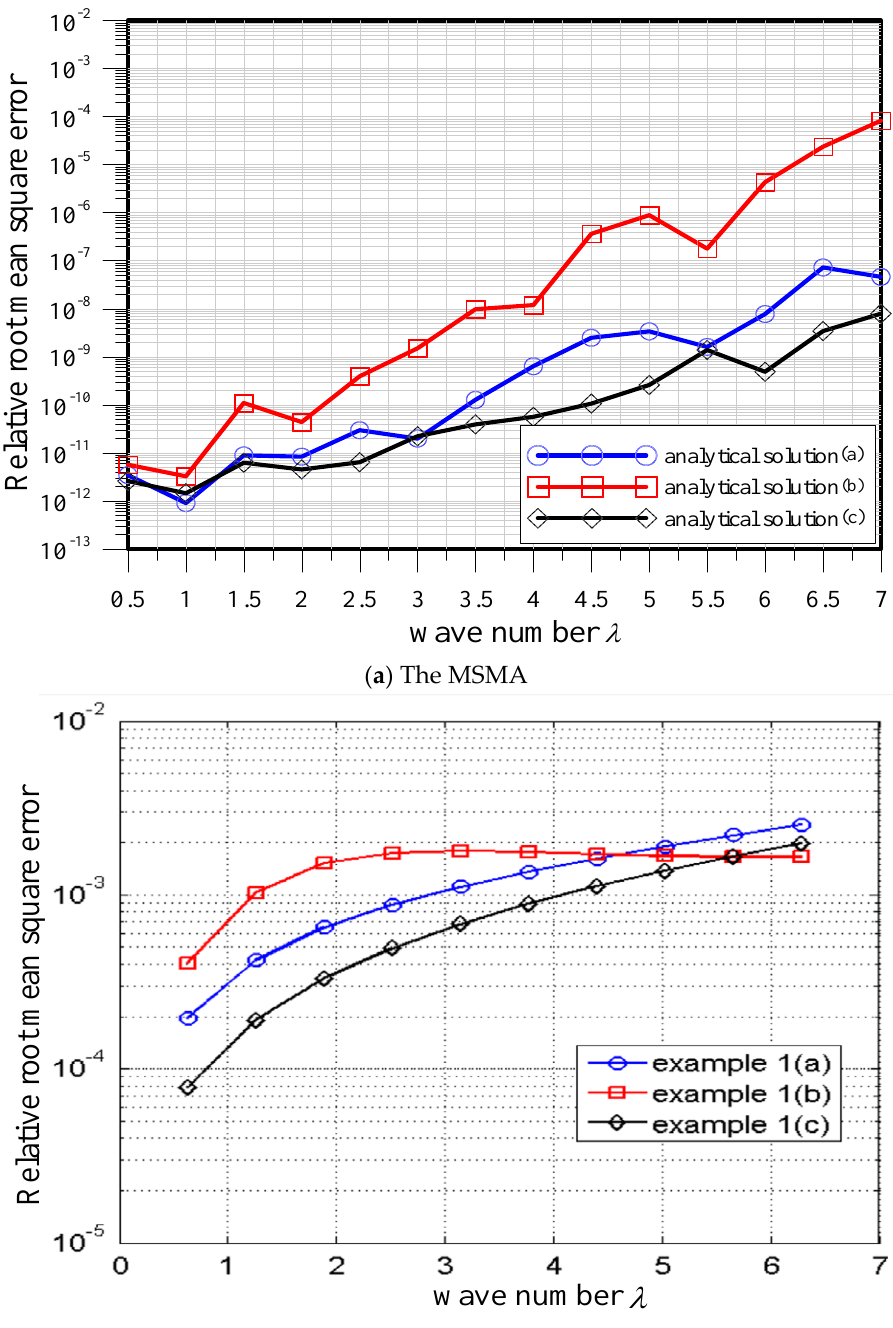
Figure 9. Accuracy comparison for the relative root-mean-square error versus the wave number: ( a ) the MSMA and ( b ) the SBM.